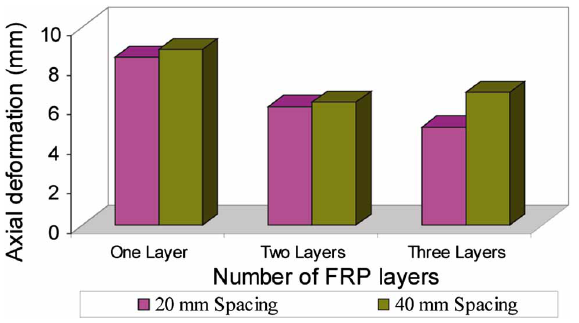
Fig. 16. Axial deformation with respect to number of CFRP layers (cid:1)